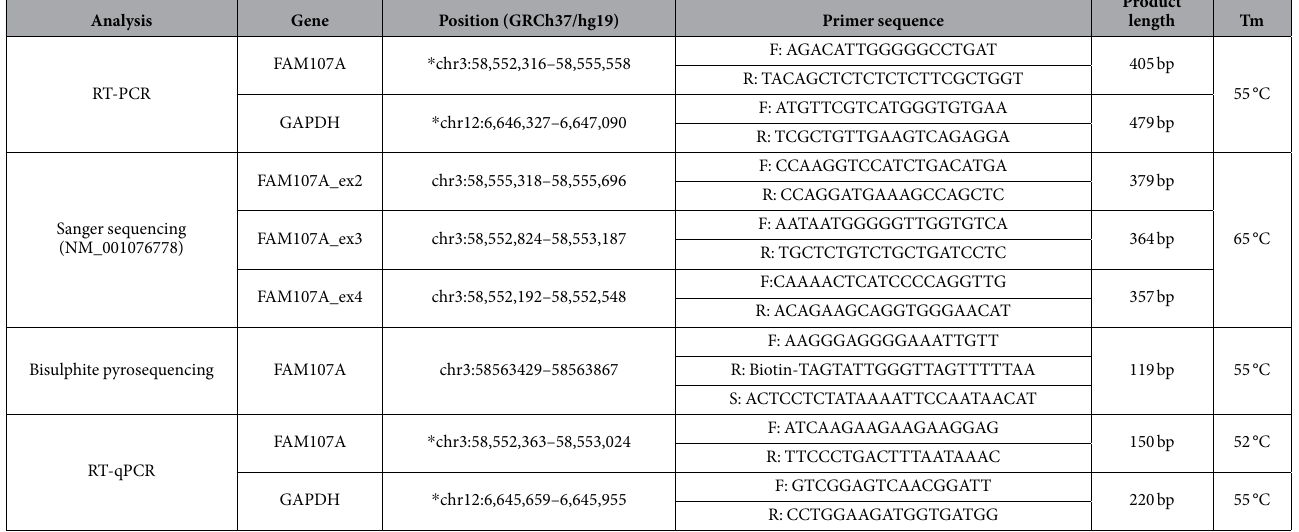
Table 3. Primer sequences, genomic localization of the amplified sequences ( * indicates genomic position including introns) and reaction